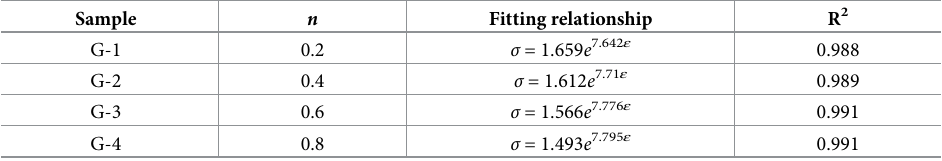
Table 2. Stress–strain fitting relationship for the broken coal and rock masses under different values of n